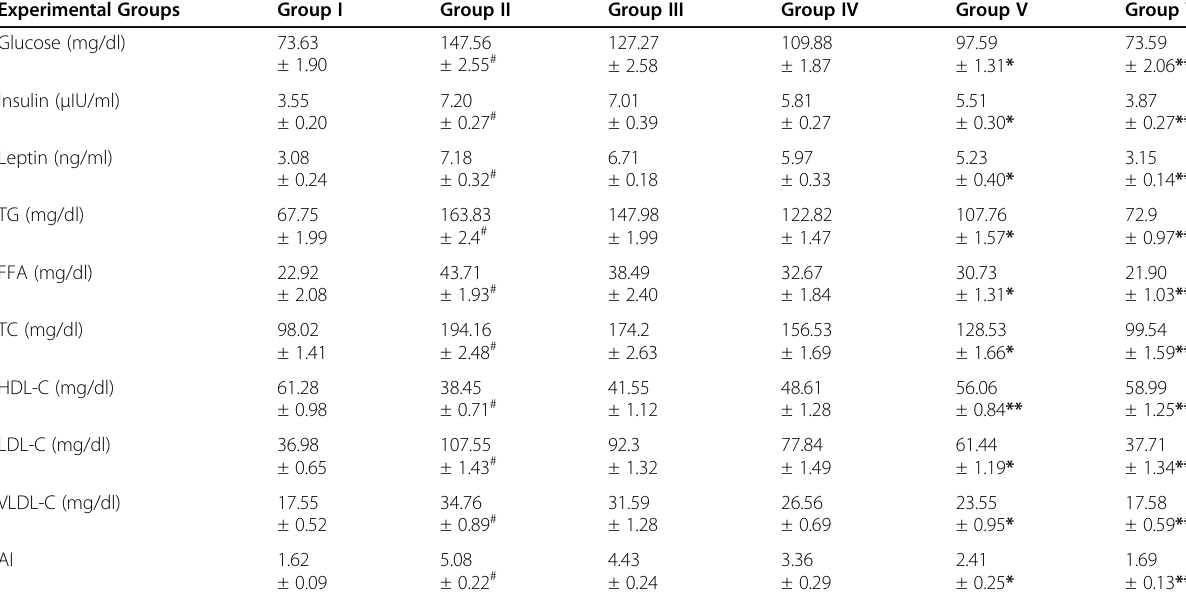
Table 3 Levels of Blood Glucose, Serum Insulin, Leptin and Lipid Profiles in Experimental Rats Experimental